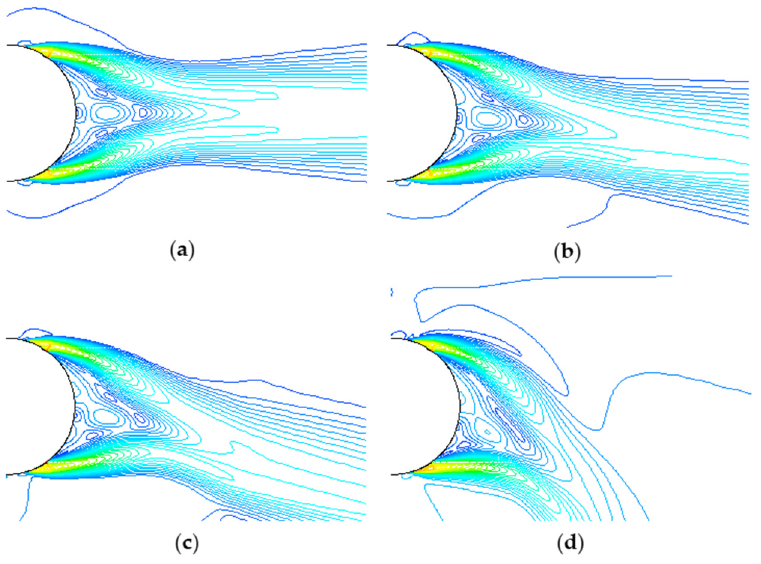
Figure 10. Mach number contours of two parallel external jets at different rotational angular velocities: ( a ) 0 r/s, ( b ) 5 r/s, ( c ) 10 r/s, ( d ) 20 r/s.